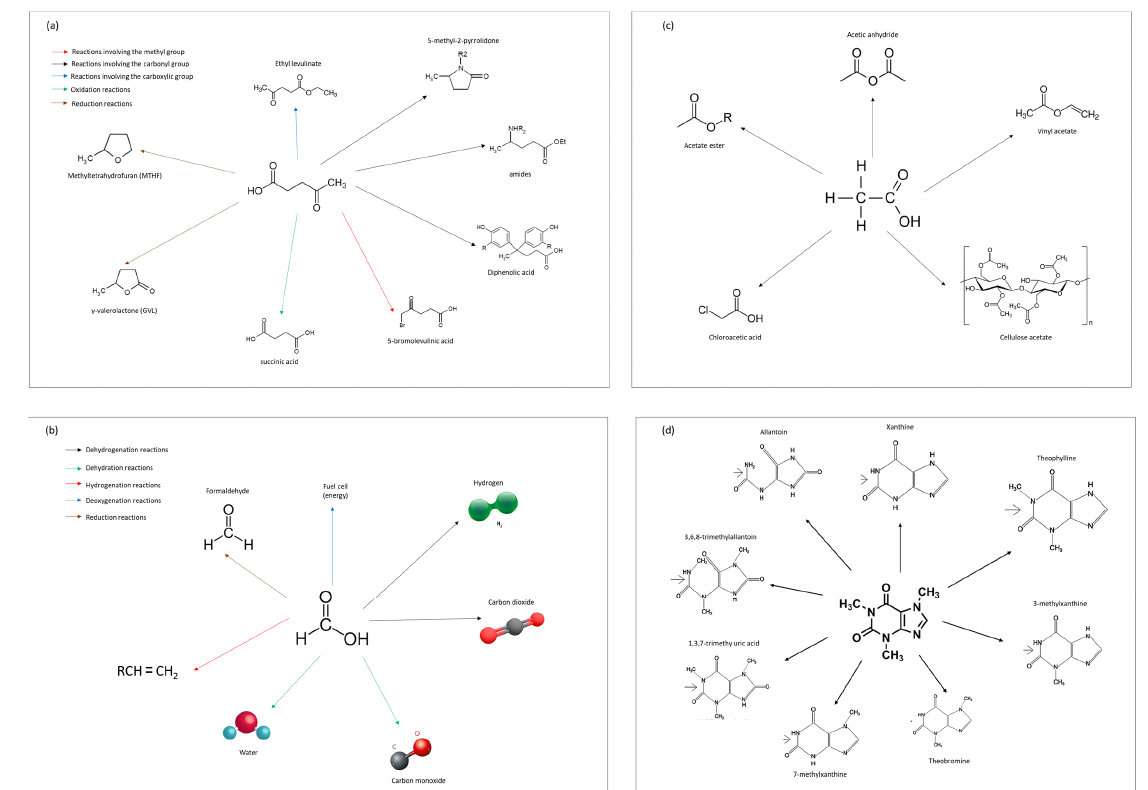
Figure 9. Derivatives of major compounds found in the liquid pyrolysate: ( a ) LA; ( b ) FA; ( c ) AA; ( d ) caffeine.